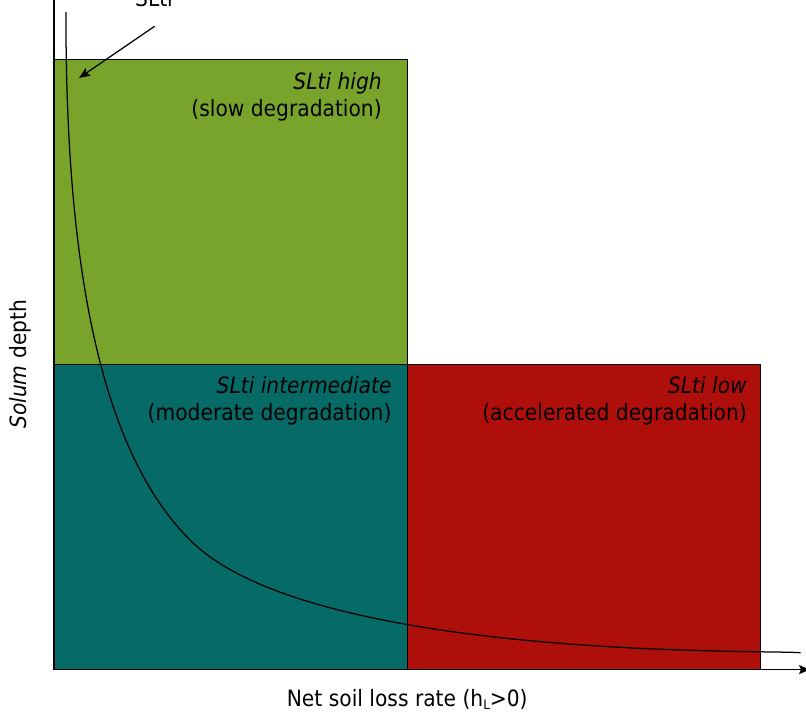
Figure 6. SltI is a function of soil depth and net soil loss rate, estimated by an erosion model.